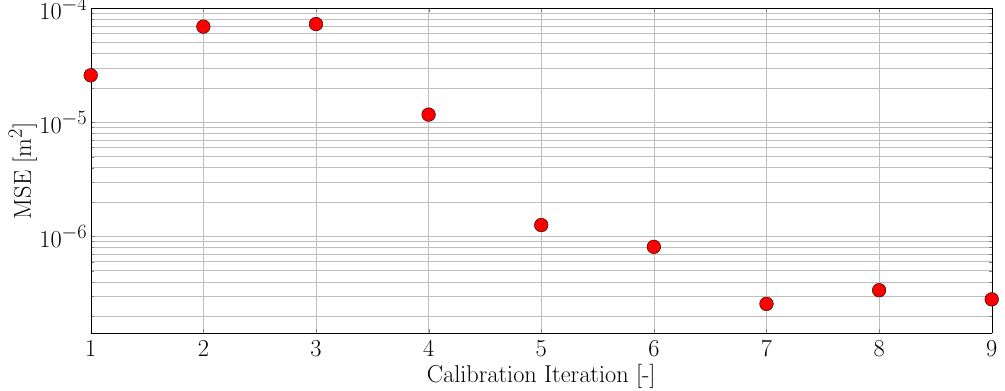
Figure 4. Example of the decrease in the MSE for increasing calibration iterations.